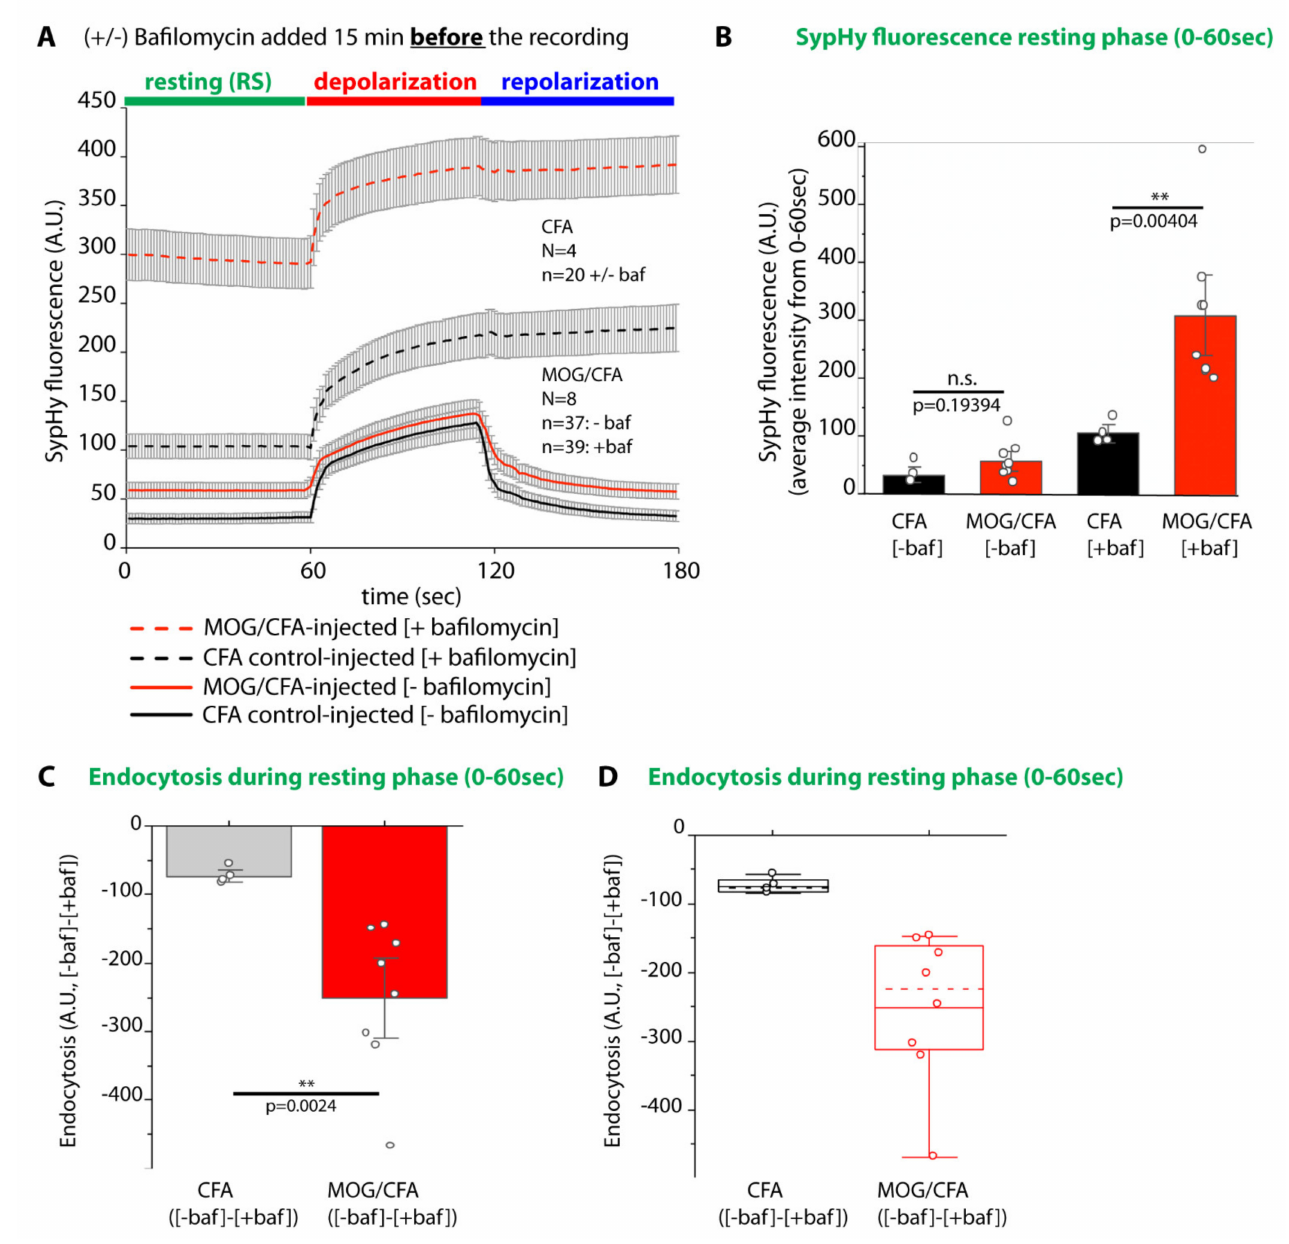
Figure 10. Basal endocytosis during the resting phase is higher in MOG/CFA-injected EAE mice compared to CFA-injected control mice. ( A ) Optical recording response of SypHy fluorescence in the OPL of MOG/CFA-injected EAE mice and CFA- injected control mice retinal slices on day 9 after injection. The slices were pre-incubated with or without bafilomycin A1 for 15 min before recording. ( A ) shows non-normalized response of SypHy fluorescence in the OPL of MOG/CFA-injected EAE mice and CFA-control injected mice in the presence and absence of bafilomycin A1. ( B ) Basal average level of SypHy fluorescence during resting stage (0–60 sec) in the presence and absence of bafilomycin A1 in MOG/CAF-injected EAE mice and CFA-injected control mice. ( C ) Total endocytosis during the resting phase (0–60 s) was determined by subtracting the basal fluorescence in the presence of bafilomycin A1 [+baf] from the basal fluorescence in the absence of bafilomycin A1 [ − baf]; i.e., ([ − baf]-[+baf]). ( D ) In the box-and-whisker plot from the data in ( C ), mean values are represented by solid horizontal line; median by dotted horizontal line. Boxes represent the 25th–75th percentile of the data points and whiskers are equal to 1.5 times of the IQR. Mann–Whitney U test was applied to obtain statistical significance in ( B ) and unpaired Student’s t -test in ( C ). N = number of mice; n = number of retinal slices used for the optical recording in the presence or absence of bafilomycin A1; n.s., not significant; **, p ≤ 0.01; RS, resting